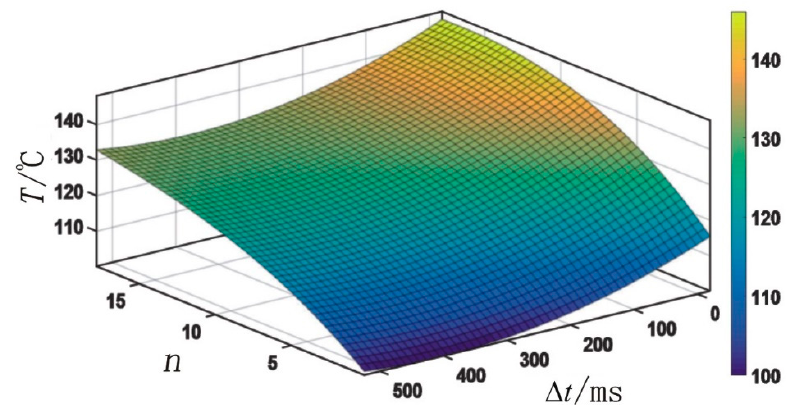
Figure 9. Average temperature rise of the ZnO varistor surface under four pulses. Figure9. Average temperature rise of the ZnO varistor surface under four pulses.